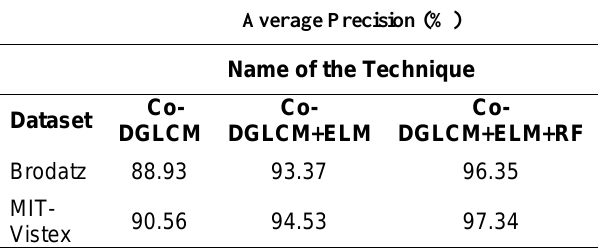
Table 4. Average Precision (%) of the proposed system During three phases of implementation